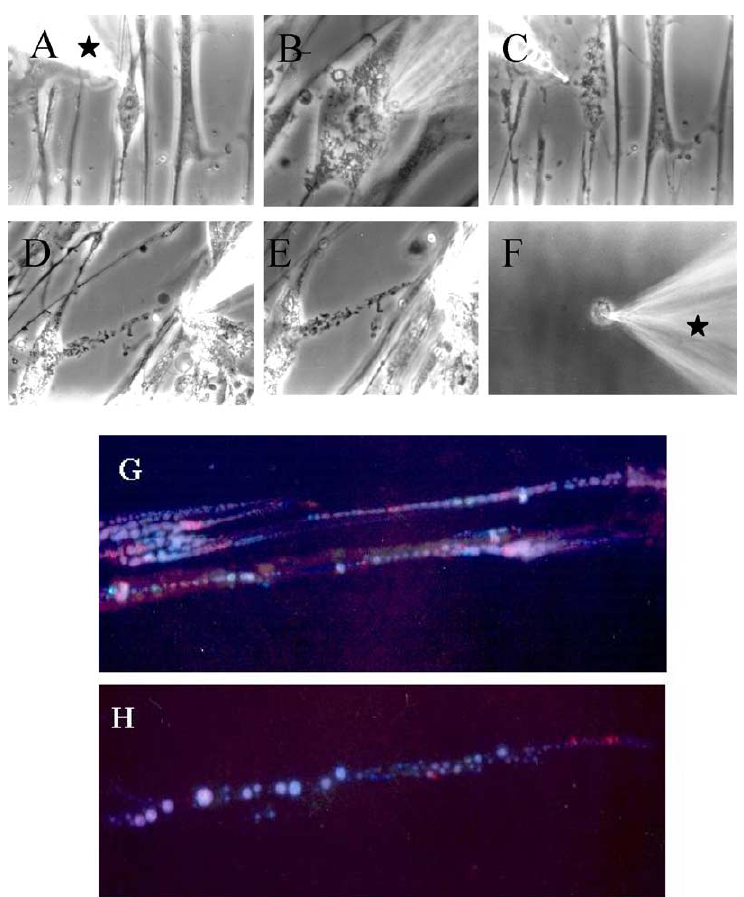
Fig. 2. (A–F) A series of photographs illustrating the steps involved in removal of chromosomes from a living human fibroblast. Pulling on individual chromosomes results in the sequential removal of all chromosomes that appear to be interconnected to one another in tandem by an elastic thread which we have called a tether. Release of the last chromosomes from the cell results in recoiling of the extracted chromsomes back into a “rosette configuration” at the tip of the microprobe. (G–H) Isolated mitotic rosettes were subjected to gentle homogenation, cytospun and exposed to unidirectional fluid shear forces. Under these conditions, ruptured chromosome rosettes formed long, linear arrays of tandemly interconnected